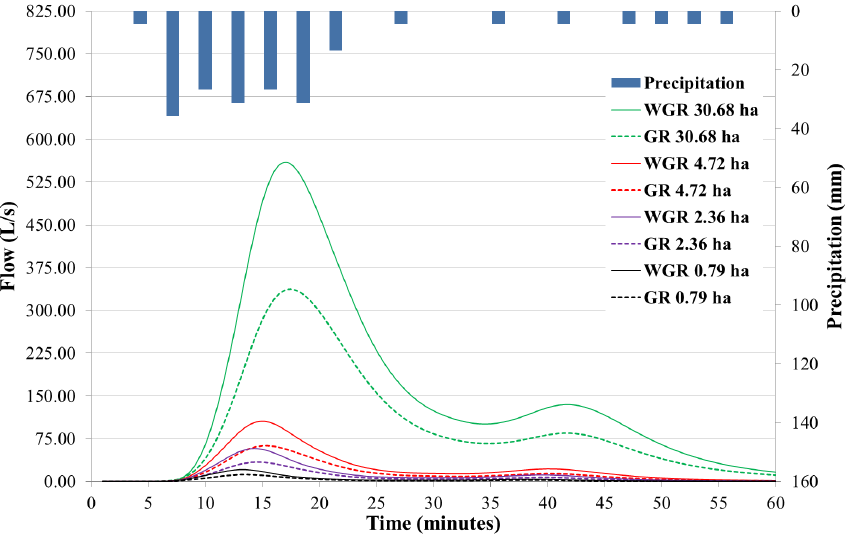
Figure 2. Hydrographs in drainage areas with 0.79, 2.36, 4.72 and 30.68ha for rainfall event 1 (WGR: without green roof; GR: with green roof).